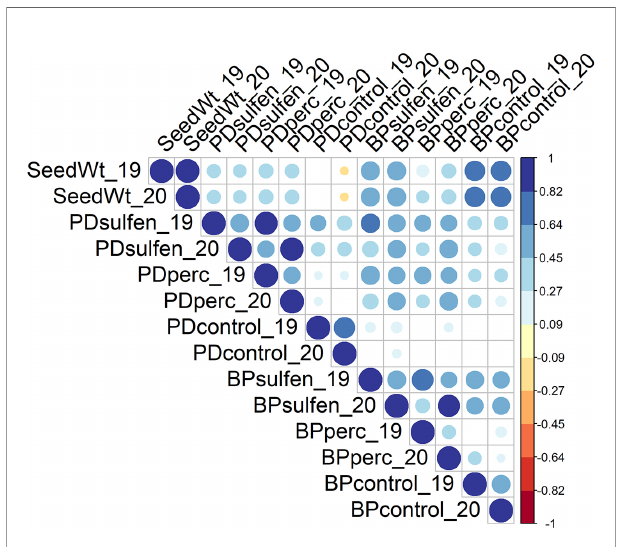
FIGURE 2 | Correlations among traits across years. The color and size of the circle depict the strength of the relationship. Only correlations with p ≤ 0.05 are